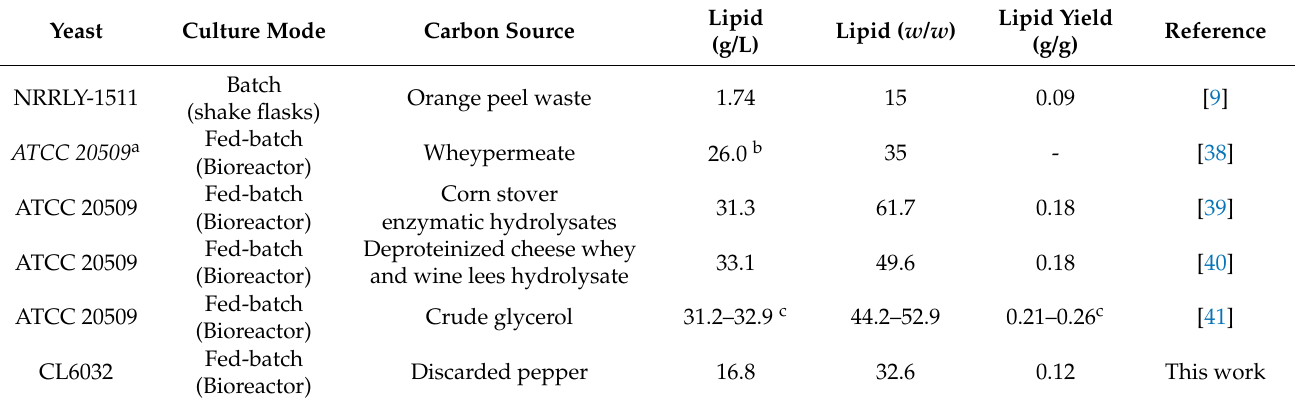
Table 7. Metrics of lipid production by several C.curvatus strain growing on low-cost carbon source.